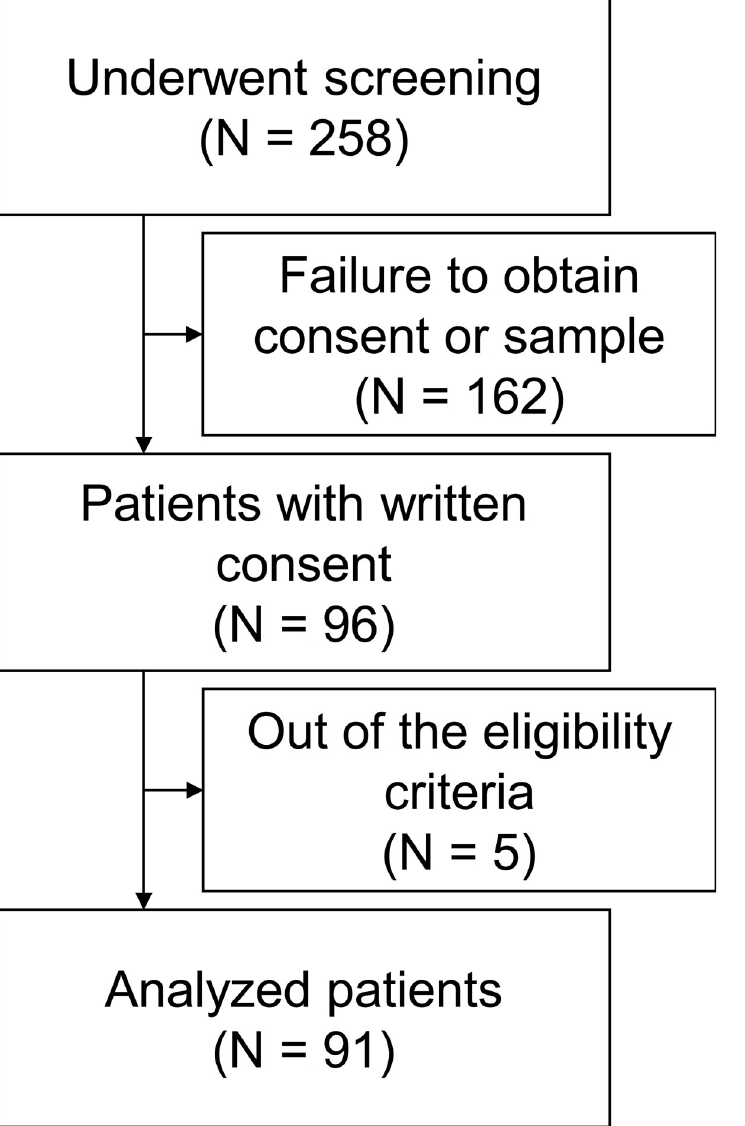
Fig 1. Patient selection. LVO, large vessel